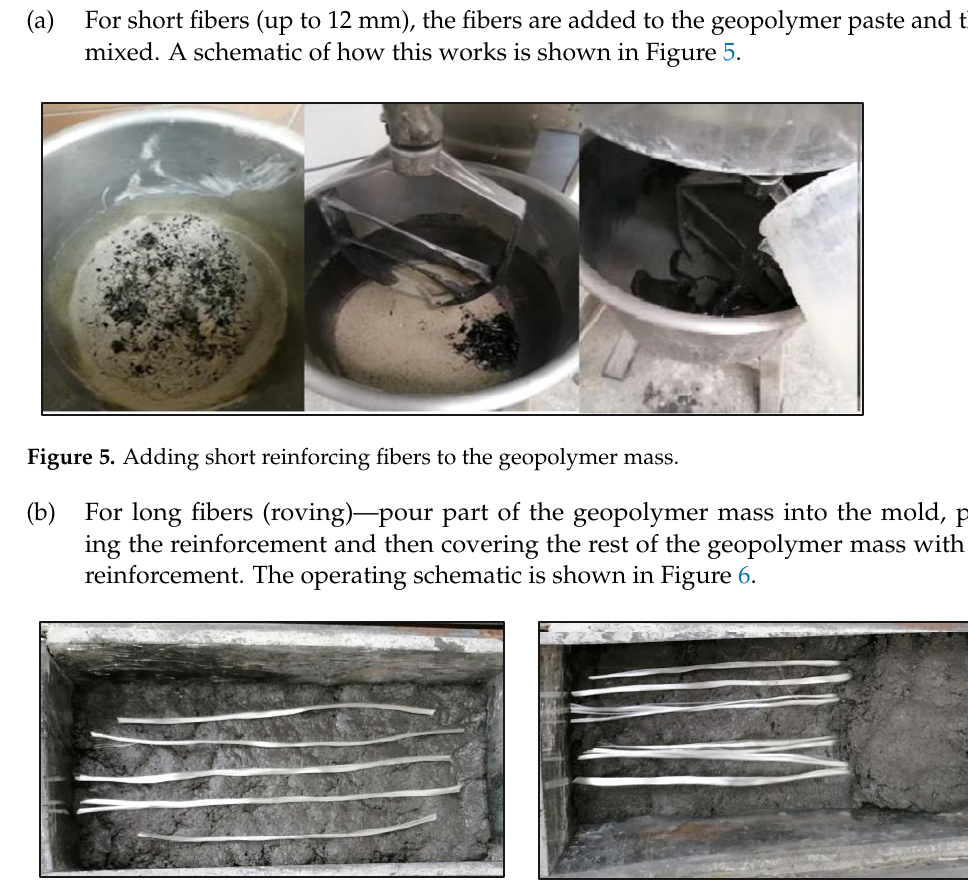
Table 4. Composition of prepared geopolymer composites reinforced with glass fiber type E.